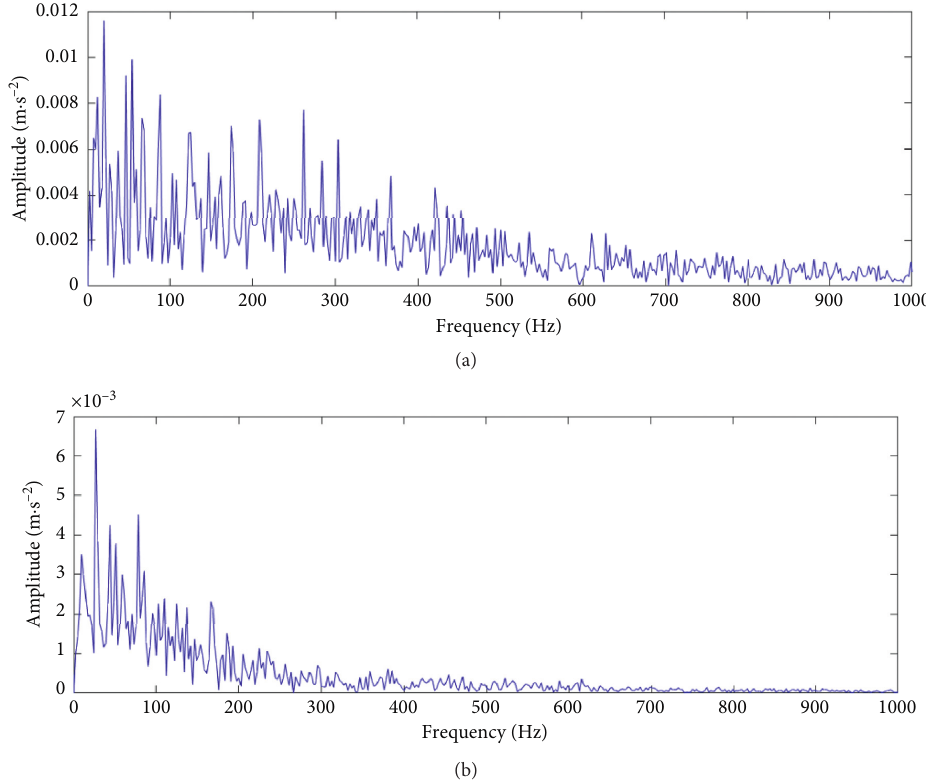
Figure 20: Envelope spectrum of sensitive IMF component by EEMD method. (a) Sensitive IMF component of inner race fault. (b) Sensitive IMF component of outer race fault.